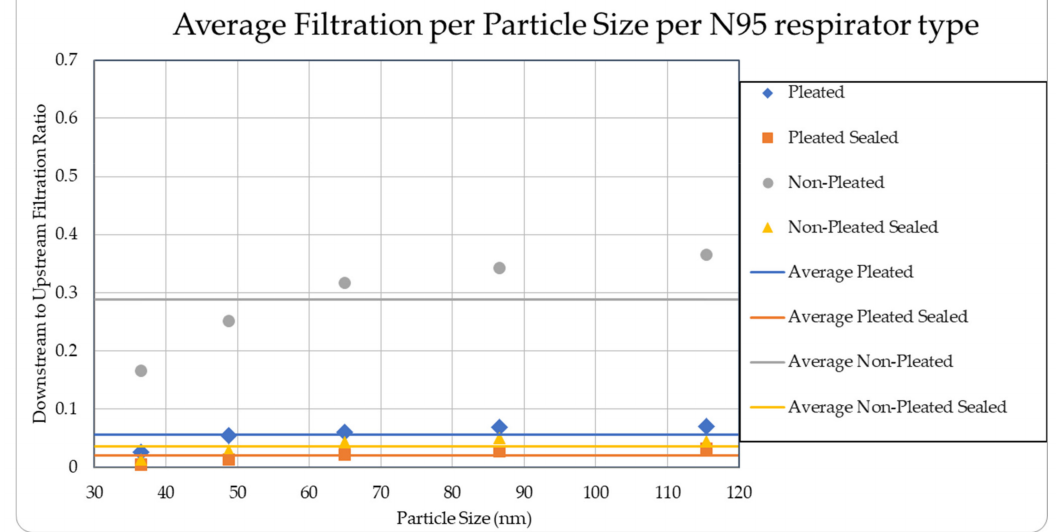
Figure 8. Average filtration ratios per type and per particle size from MIG